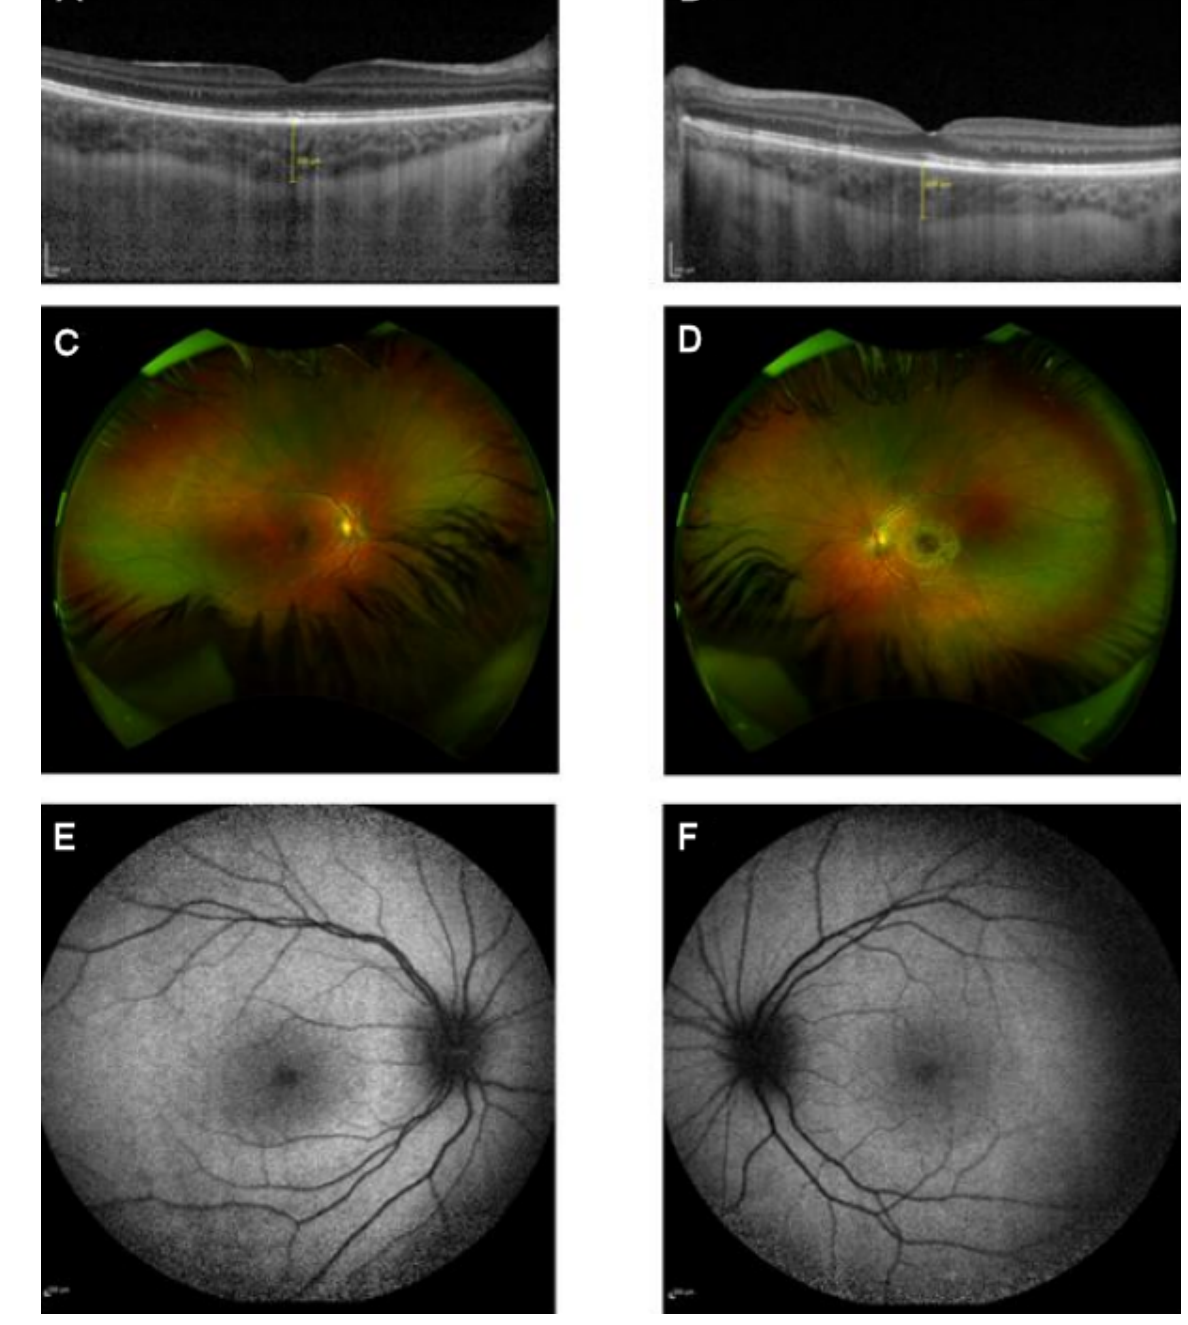
Figure 4: Three months after initial presentation, there was total resolution of the exudative retinal detachments in the right (A) and left (B) eye with normalization of choroidal thickness and an almost complete resorption of the vitelliform lesions (C, D). Autofluorescence was normal (E,